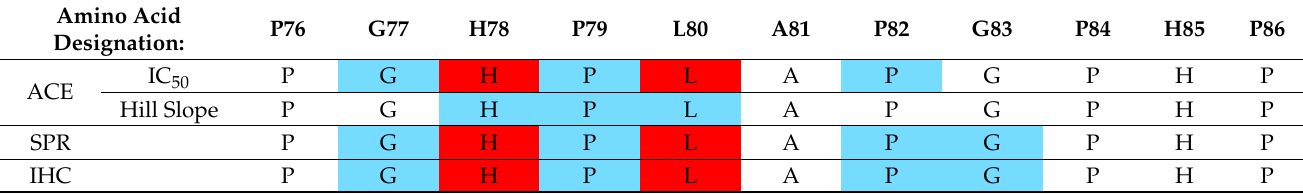
Table 2. Summary of critical (red background), contributory (blue background), and residues without effect (white background) on the SP464 antibody-peptide binding event as determined by ACE, SPR, and